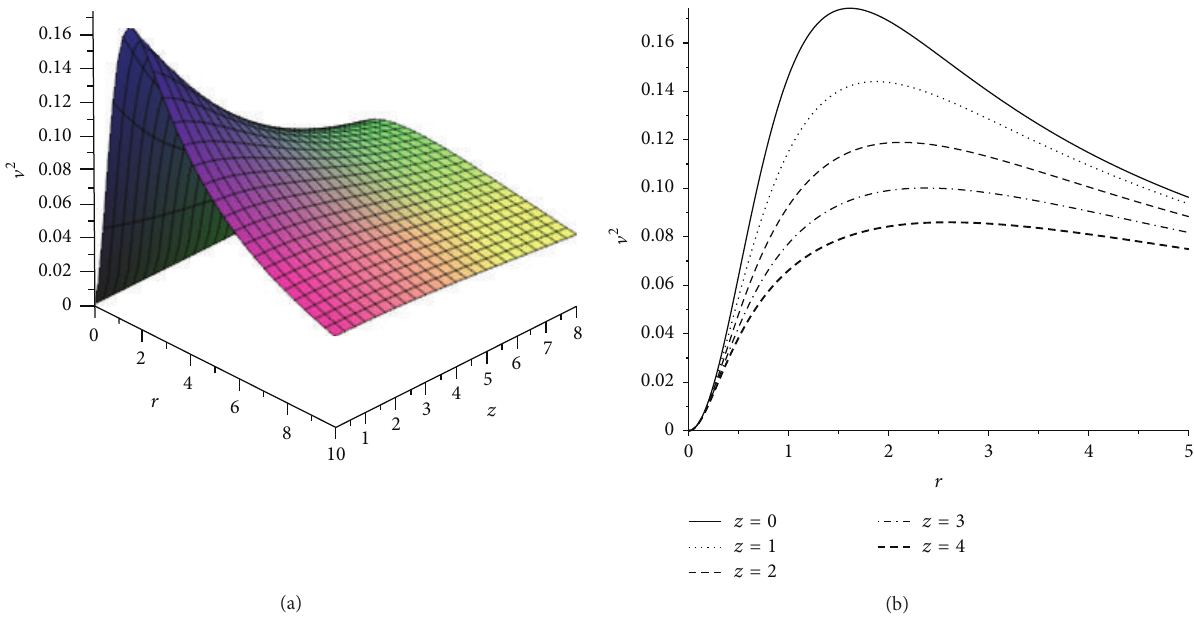
Figure 4: Surface plot of the velocity (a) V 2 1 and 𝑧 -slices of the surface plot of the velocity (b) on the halo as functions depending on 𝑟 and 𝑧 with parameters 𝑎 = 𝑏 0 = 𝑏 1 = 𝑘 = 𝑘 𝜔 = 1 and 𝛽 = 0.75